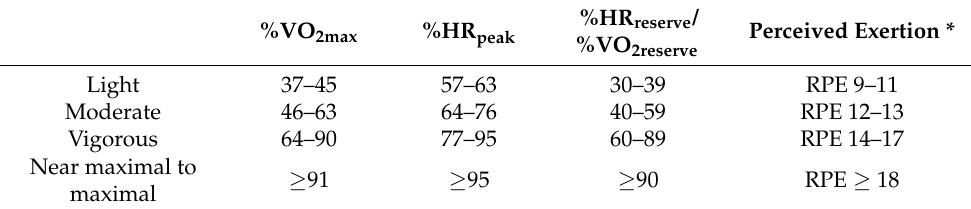
Table adapted from American College of Sports Medicine (ACSM) [28] and Mitchell et al. [23]. * As per the Borg 6–20 RPE scale. %VO 2 max, percentage of maximal oxygen uptake; %HRpeak, percentage of peak heart